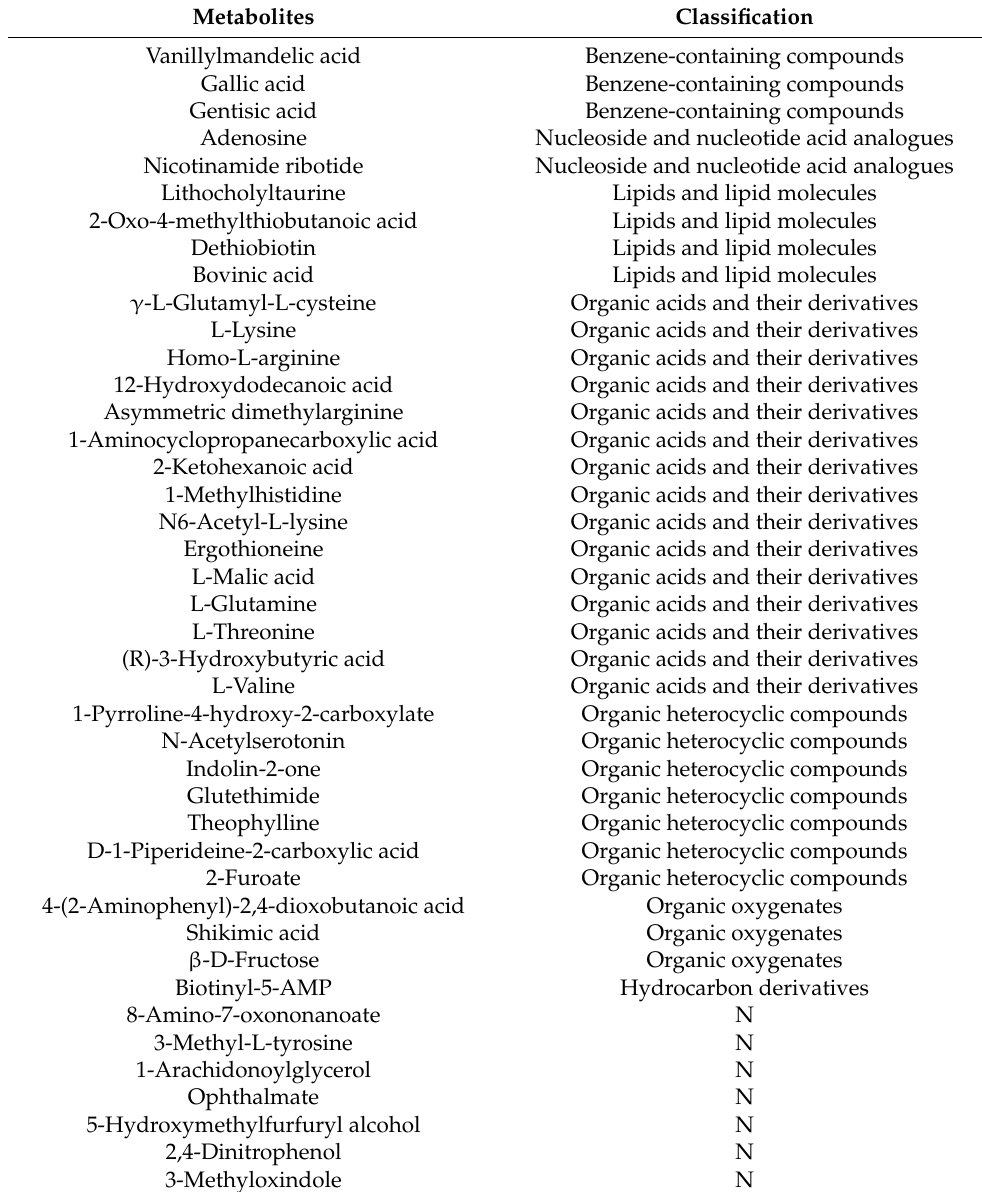
Table 6. Basic information of different metabolites identified in breast